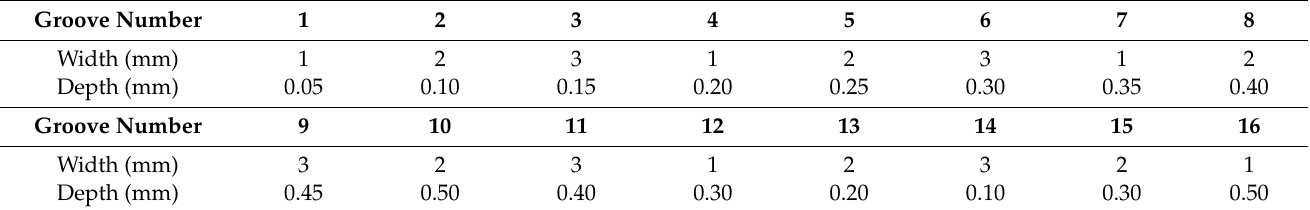
Figure 6. Flat physical map.